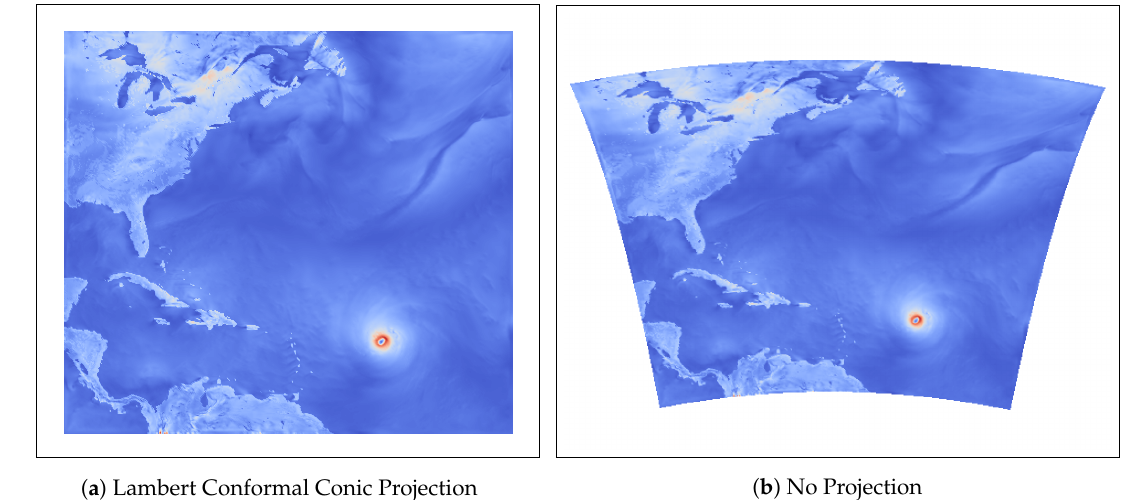
Figure 8. 2D pseudocolor rendering of 2009’s Hurricane Bill simulation using VAPOR with Lambert conformal conic projection enabled ( a ) and disabled ( b ). The rendered variable is friction velocity (UST), and the data are in WRF